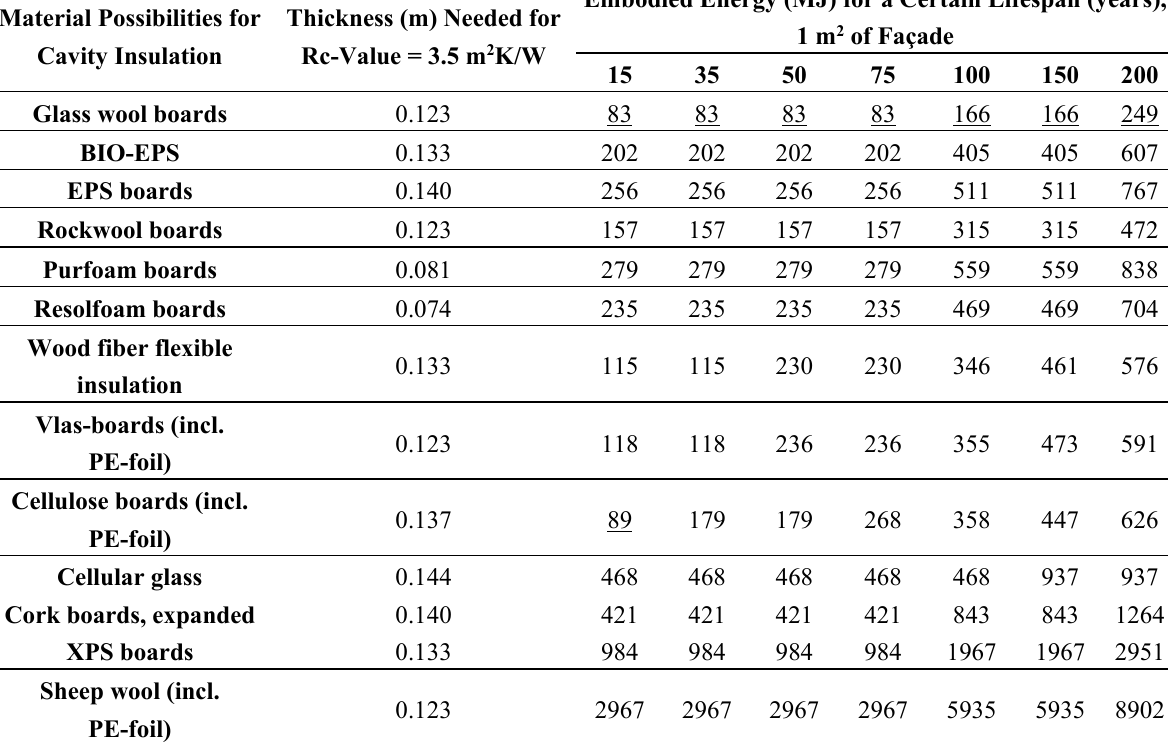
Table 1. Embodied energy comparison for cavity insulation materials, for 1 m 2 of façade. The results are shown for different building lifespans. The underlined values show the lowest embodied energy per lifespan.